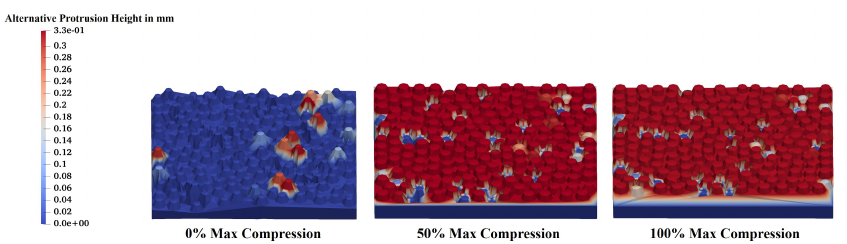
Figure 38. Grit 20 ( d mean = 0.85 mm) surface topography with alternative protrusion height at 0%, 50%, and 100% maximum compression.